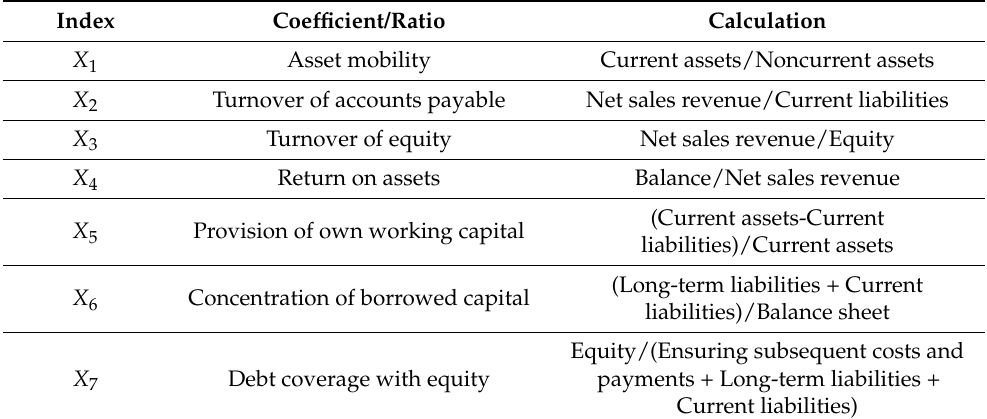
Table 1. Matviychuk’s model.